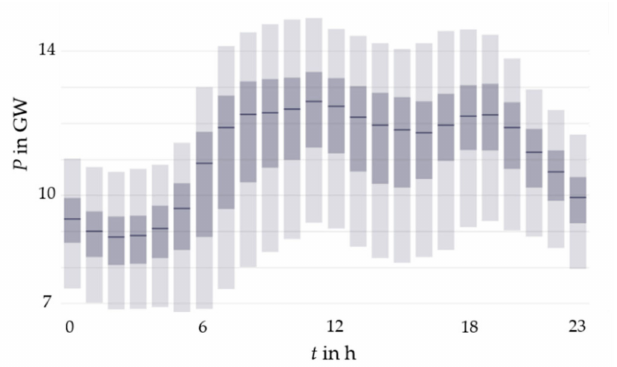
Figure 5. Boxplot total load for the 50 Hertz area: typical course of the load during a